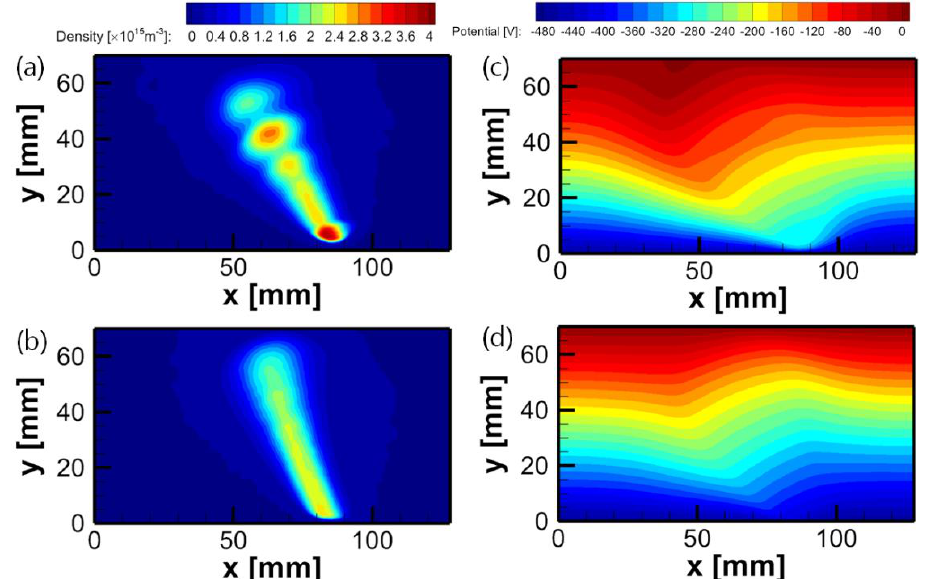
Figure 3. ( Left ) Plasma densities with the maximum magnetic flux densities of ( a ) 350 G and ( b ) 500 G. ( Right ) Electric potentials with the maximum magnetic flux densities of ( c ) 350 G and ( d ) 500 G.